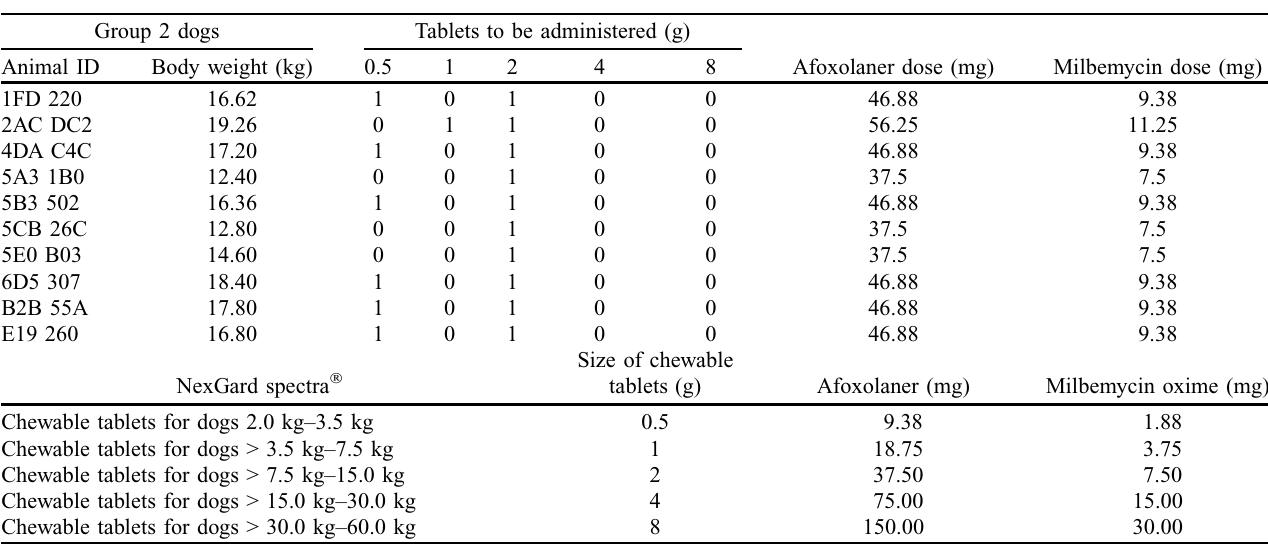
Table 1. Experimental design. Table 2. Administered tablet doses per individual dog in treated group. Group 2 dogs